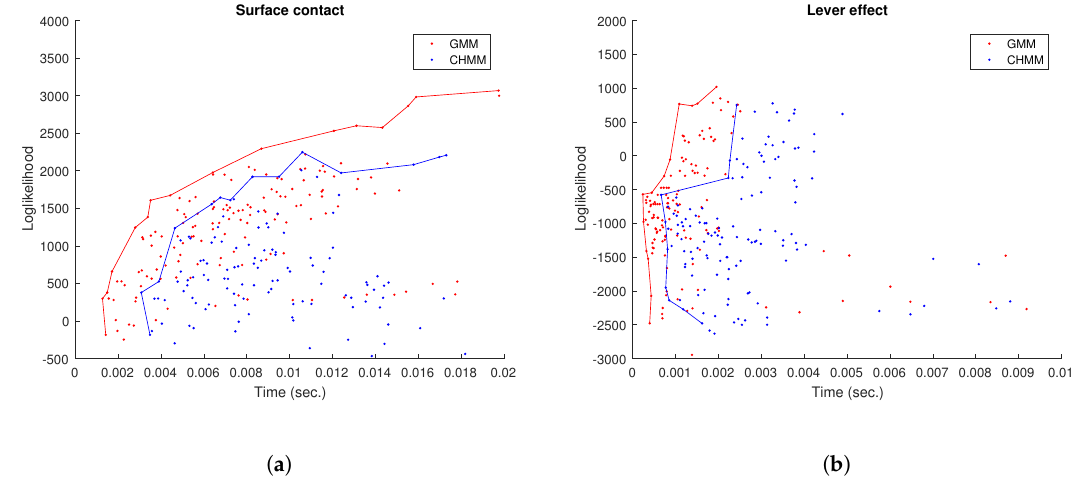
Figure 12. Pareto frontier for GMM and CHMM using the log-likelihood and processing time of each evaluation movement for both gestures: ( a ) surface contact gesture; and ( b ) lever effect gesture.